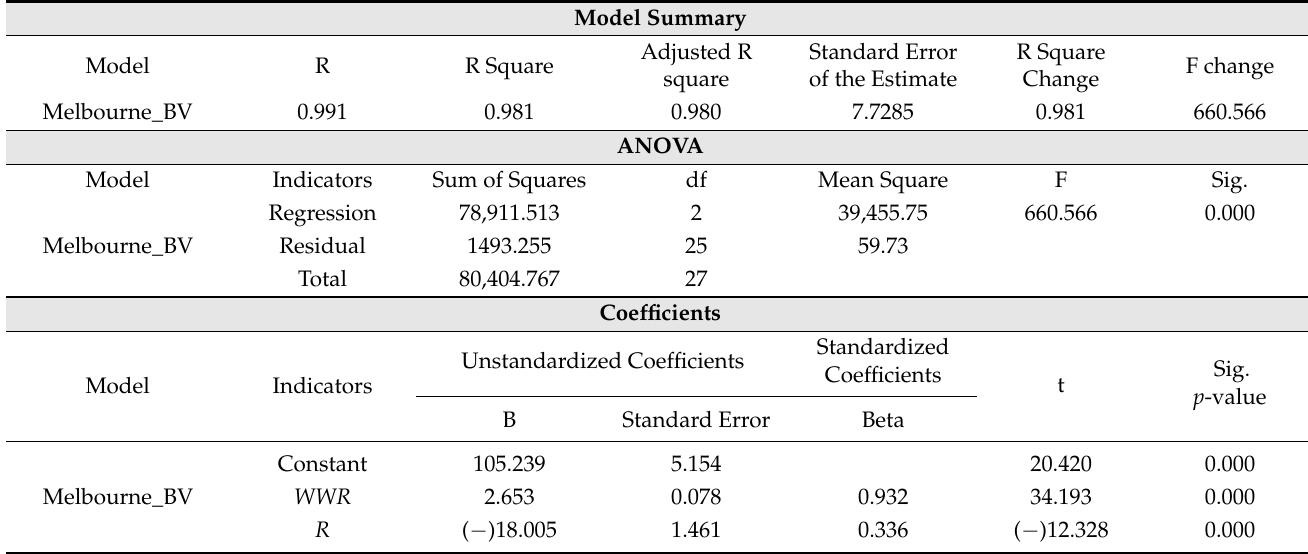
Table 2. Energy consumption model in Melbourne from the effect of insulation ( R ) and windows to wall ratio ( WWR ) in percentage (%) as independent